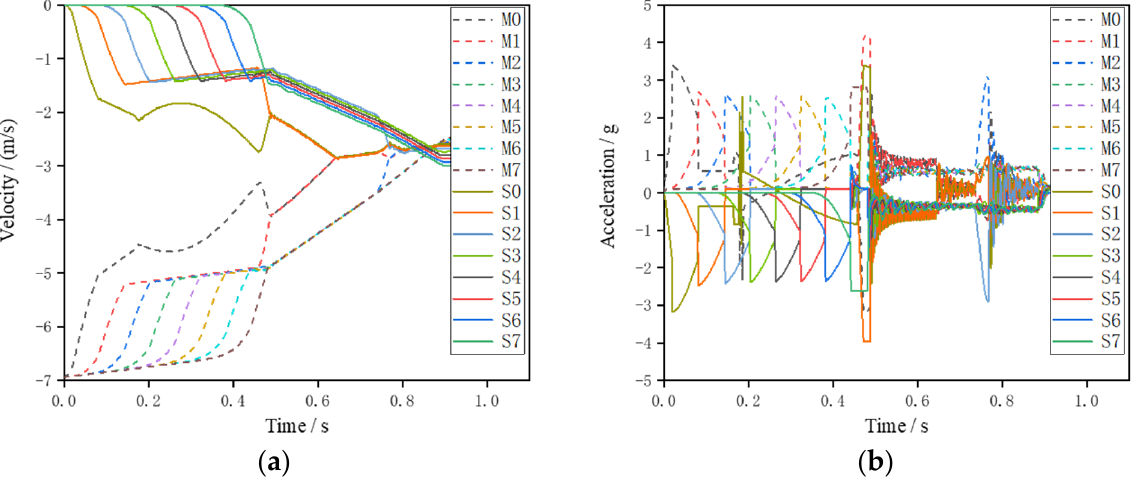
Figure 7. Velocity–time and acceleration–time graphs for each vehicle: ( a ) velocity–time, ( b ) accel- eration–time.